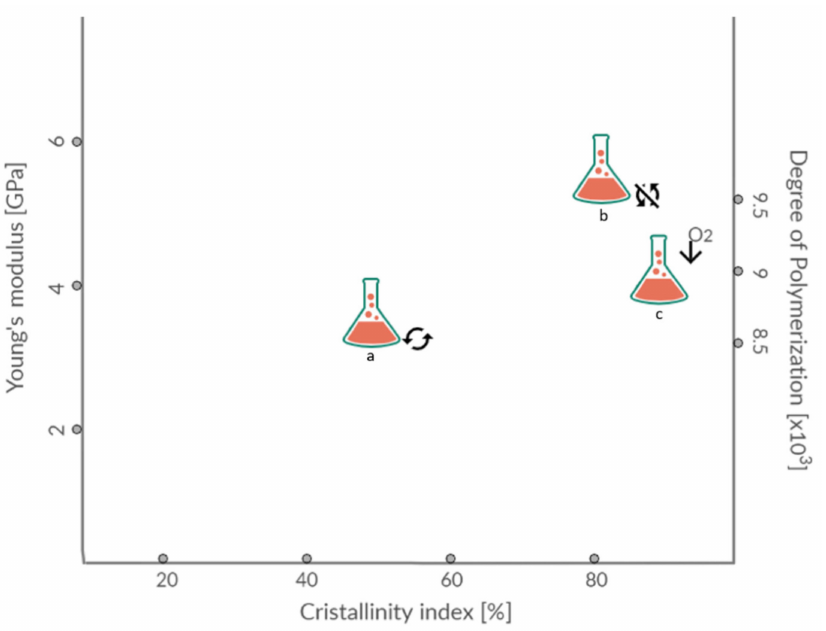
Figure 1. Young’s modulus, crystallinity index and degree of polymerisation of BC depending on cultivation conditions: a—with shaking, b—without shaking, c—with additional oxygen